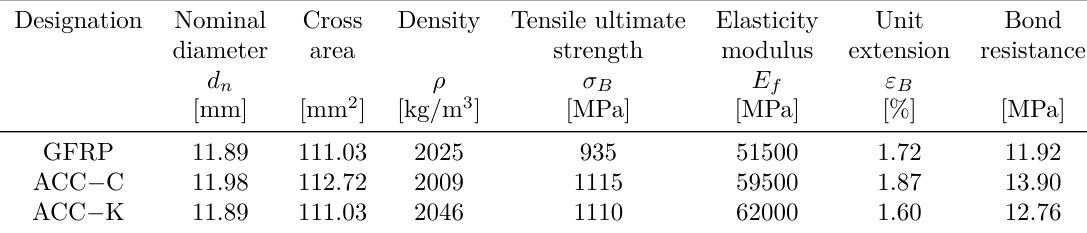
Table 1. Composition of HCR experimental samples